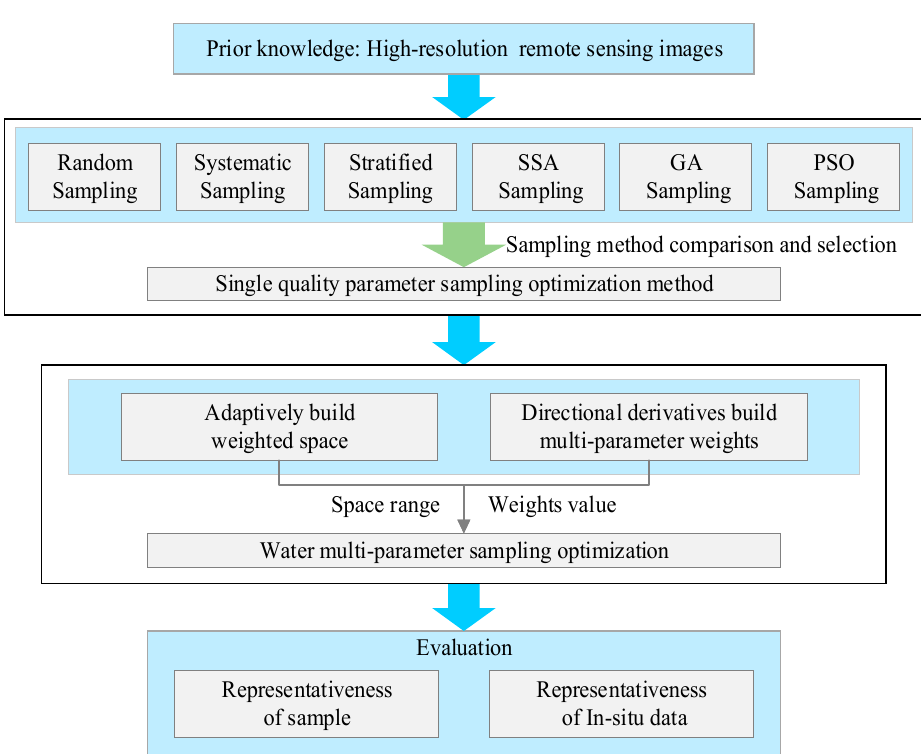
Figure 2. Flowchart of the method used in this paper.